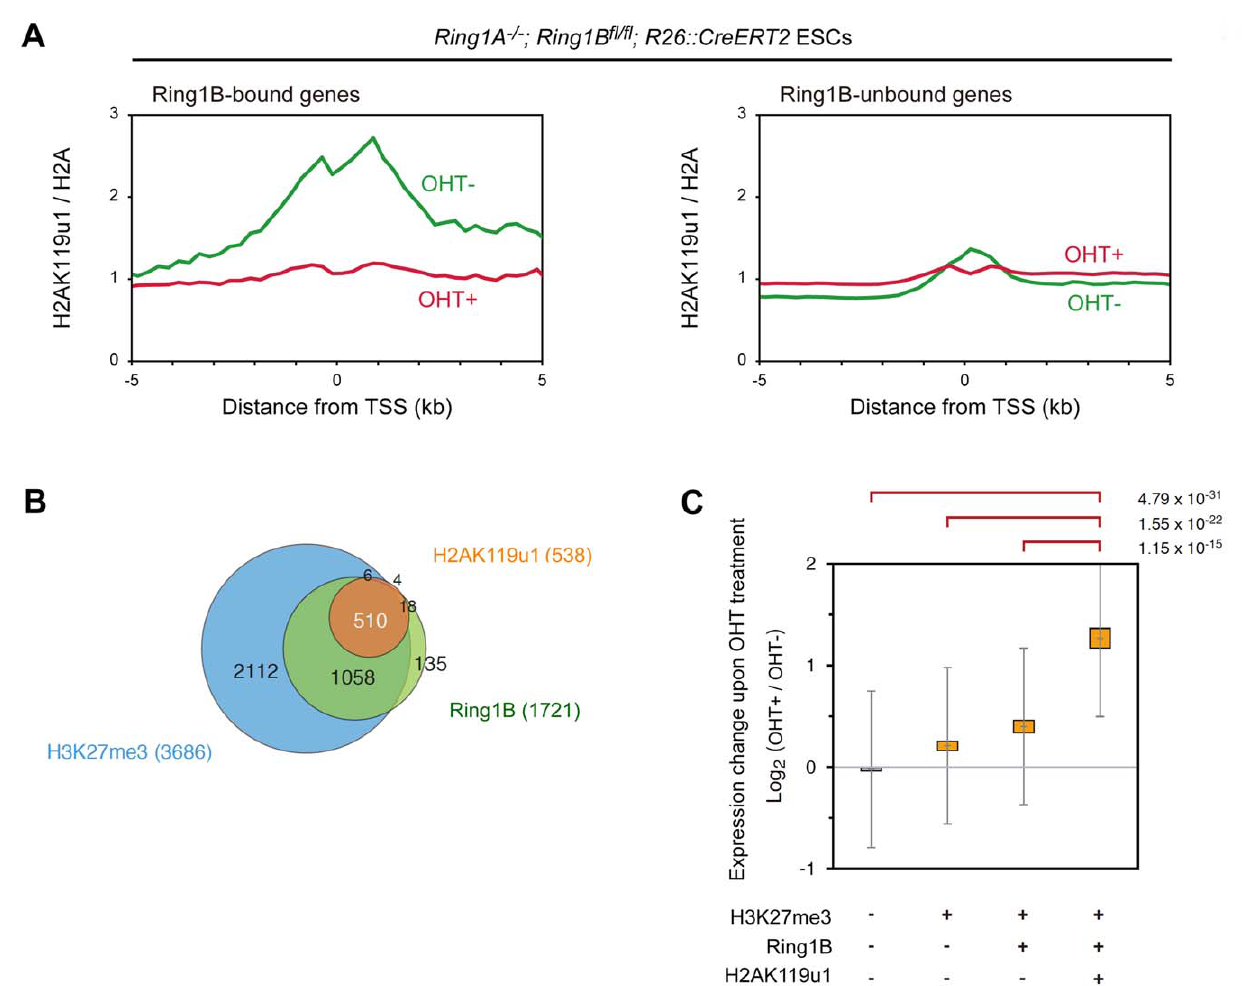
Figure 1. Global mapping of Ring1B-dependent H2AK119u1 deposition in ESCs reveals that genes occupied by H2AK119u1 represent central targets of PRC1. (A) ChIP-on-chip analysis showing the average of H2AK119u1 distributions at the promoter regions (from 2 5 kb to + 5 kb relative to TSS) of Ring1B-bound and –unbound genes in Ring1A 2 / 2 (OHT 2 : green line) and Ring1A/B -dKO (OHT + : red line) ESCs. Enrichment of H2AK119u1 (obtained by E6C5 mAb) and H2A is expressed relative to input DNA, and H2AK119u1 is normalized to H2A. (B) Venn diagram representing the overlap among genes occupied by Ring1B, H2AK119u1 and H3K27me3. Numbers in parentheses represent the total number of genes occupied by each one. (C) Graphic representation of expression changes induced by Ring1B depletion (2 days after OHT treatment) for each subset of genes classified by the presence ( + ) or absence ( 2 ) of Ring1B, H2AK119u1 and H3K27me3 is shown. The average, deviation and distribution of the expression changes for the respective subsets of genes determined by microarray analysis are shown. The 95% Confidence interval (CI) and standard deviation (SD) for the average value of the expression change are indicated. Significant ( P , 0.001) and insignificant ( P $ 0.01) expression changes were determined by the Student’s t -test and are indicated in orange and grey, respectively. P -values for the difference of expression changes between the indicated 2 groups are calculated by the Student’s t -test and are indicated above each graph.